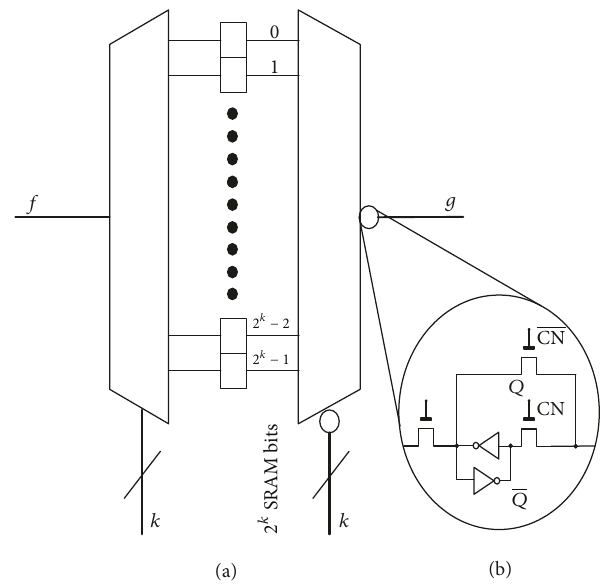
Figure 1: (a) LUTs with shared SRAM vectors and (b) CN